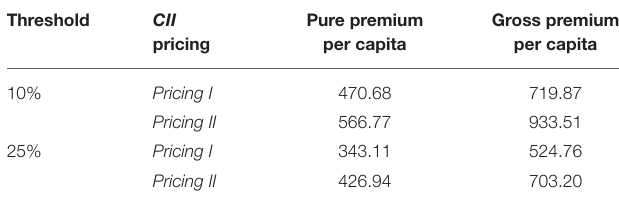
TABLE 6 | The CII pricing simulation in the basic